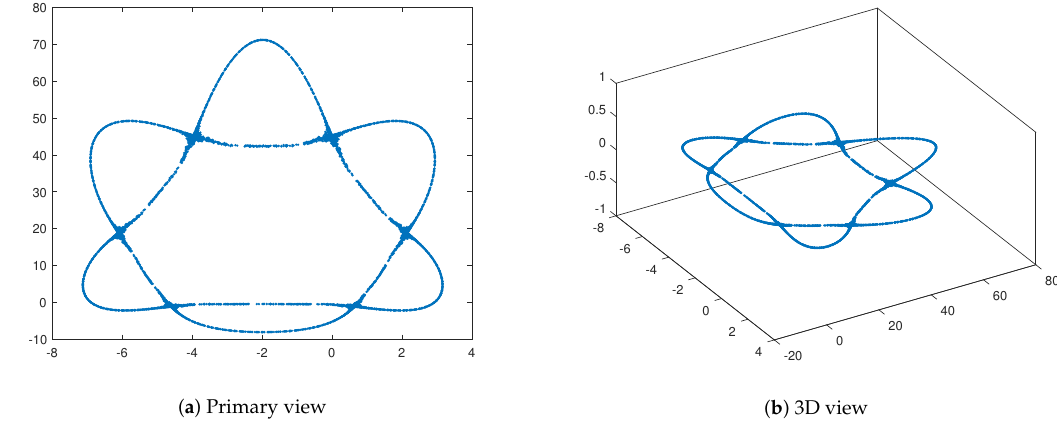
Figure 1. Modified rotation equations with θ = 2, a = 2.8, x 0 = 0.2343214592 and y = −